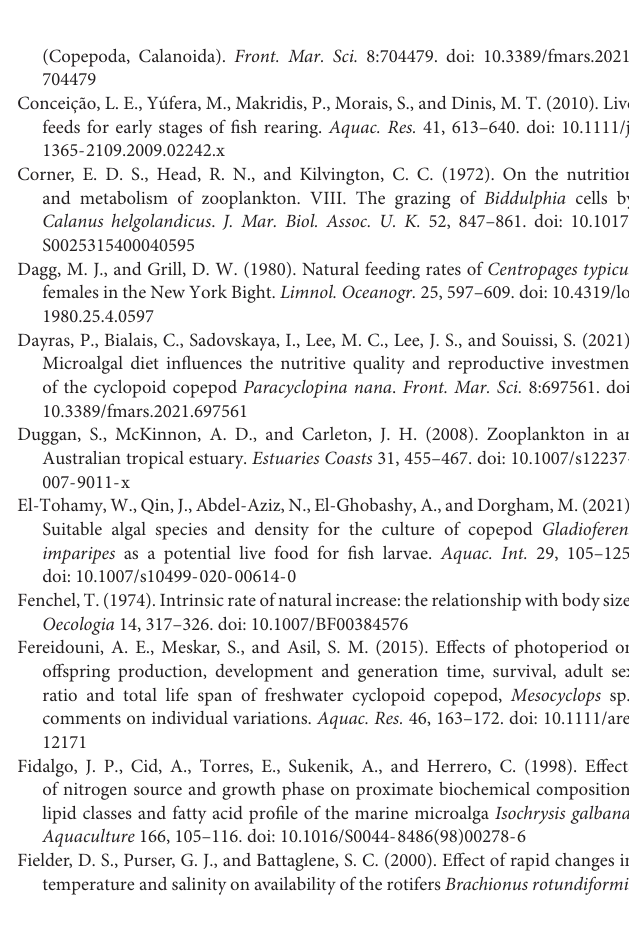
Supplementary Table 1 | Concentrations of Isochrysis spp. from five different treatment groups after 24 h of incubation with the experimental Bestiolina amoyensis